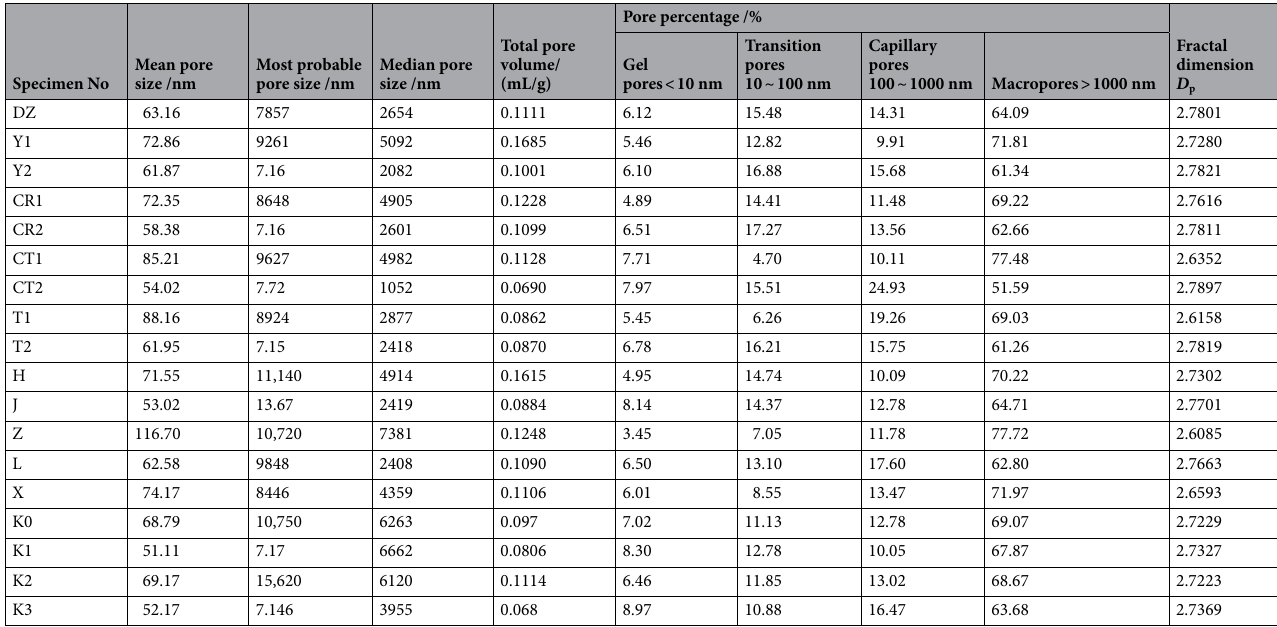
Table 3. Pore structure